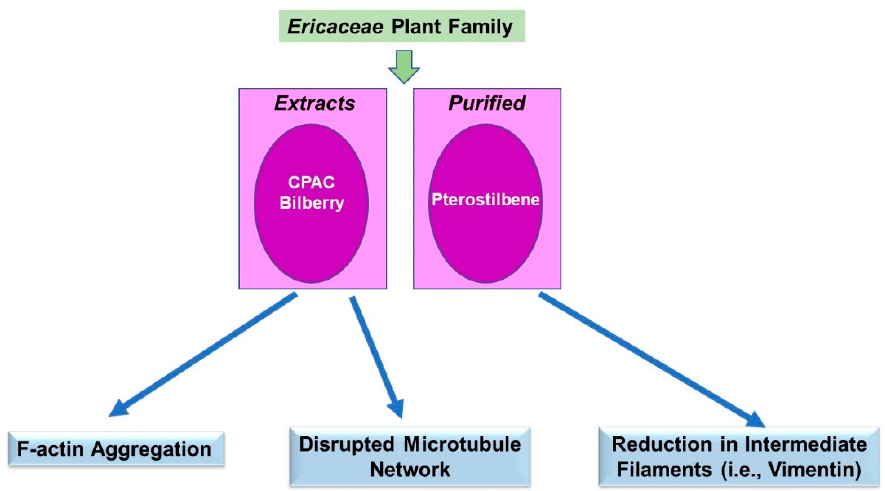
Figure 4. A schematic summary of the effects of metabolites from Ericaceae on cytoskeletal